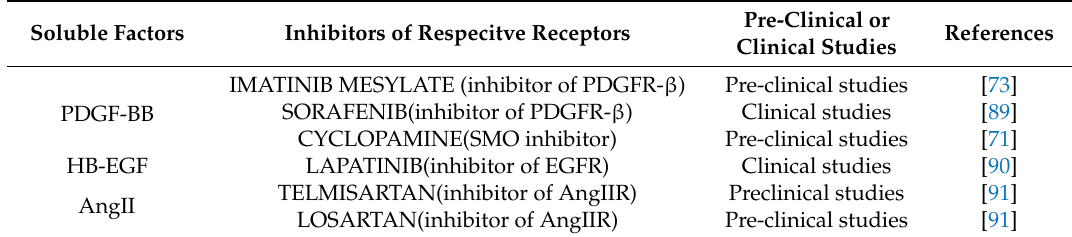
Table 3. Some of CCA soluble factor-receptors as potential druggable